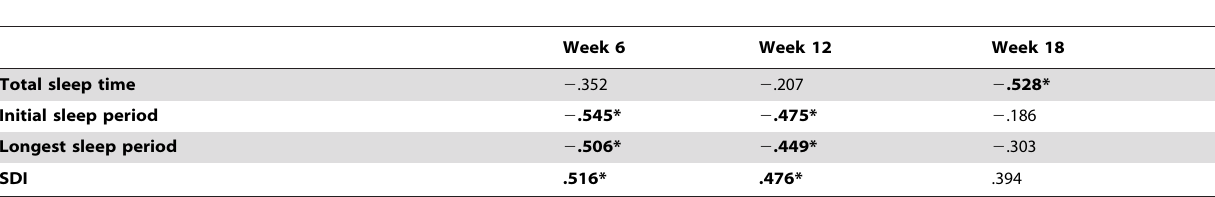
Table 2. Correlation between KSS and nocturnal sleep